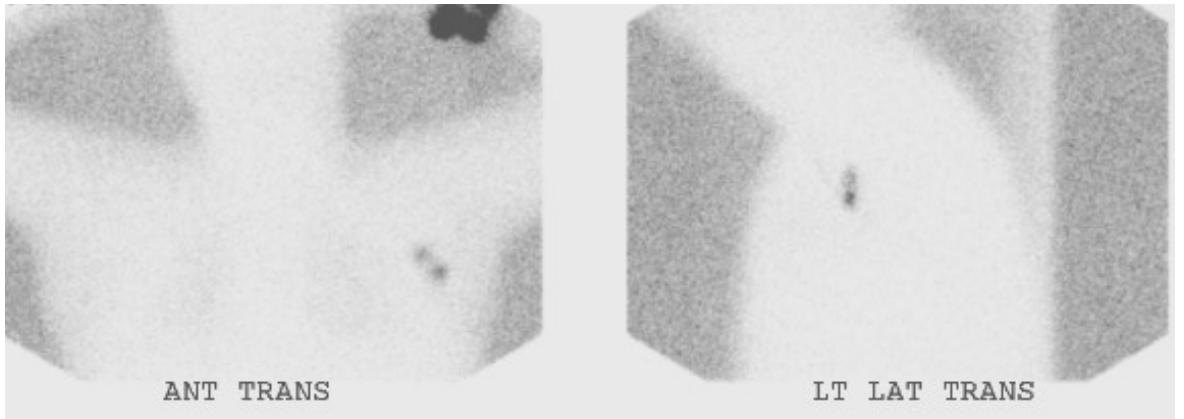
Figure 5. Sentinel node scintigraphy in a patient with MCC of the left